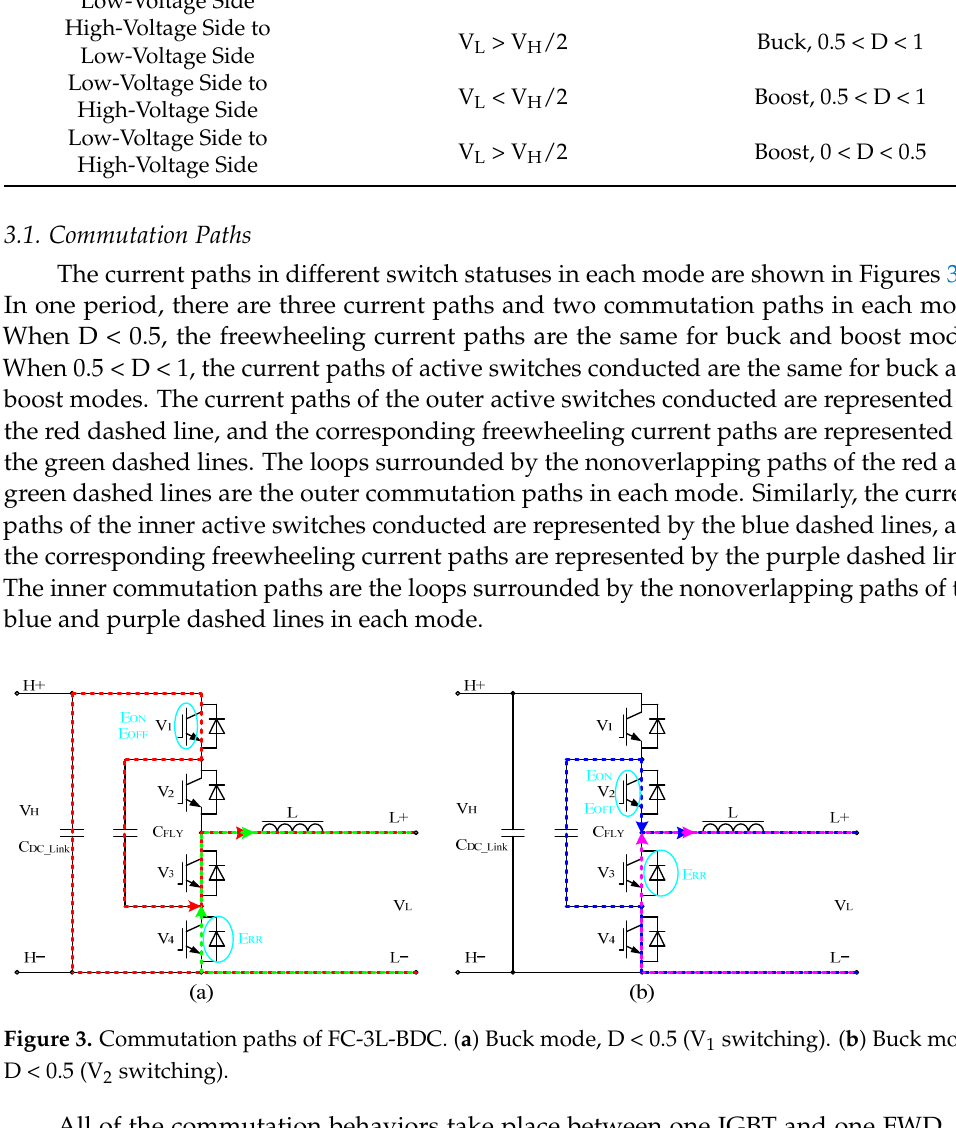
Figure 4. Commutation paths of FC ‐ 3L ‐ BDC. ( a ) Buck mode, 0.5 < D < 1 (V 1 switching). ( b ) Buck mode, 0.5 < D < 1 (V 2 switching).